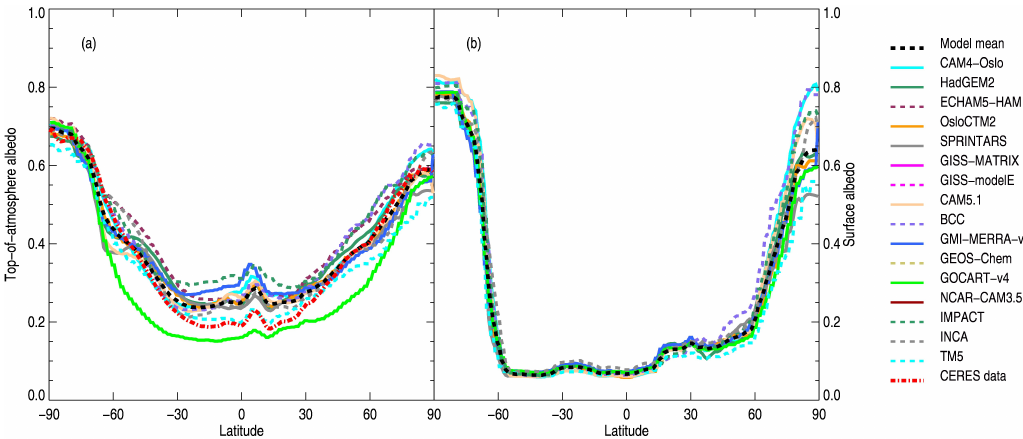
Fig. 1. Zonal mean top of the atmosphere short wave (TOA) albedo (a) and effective broadband surface albedo (b) shown for all the models. CERES TOA albedo data is shown together with the models.